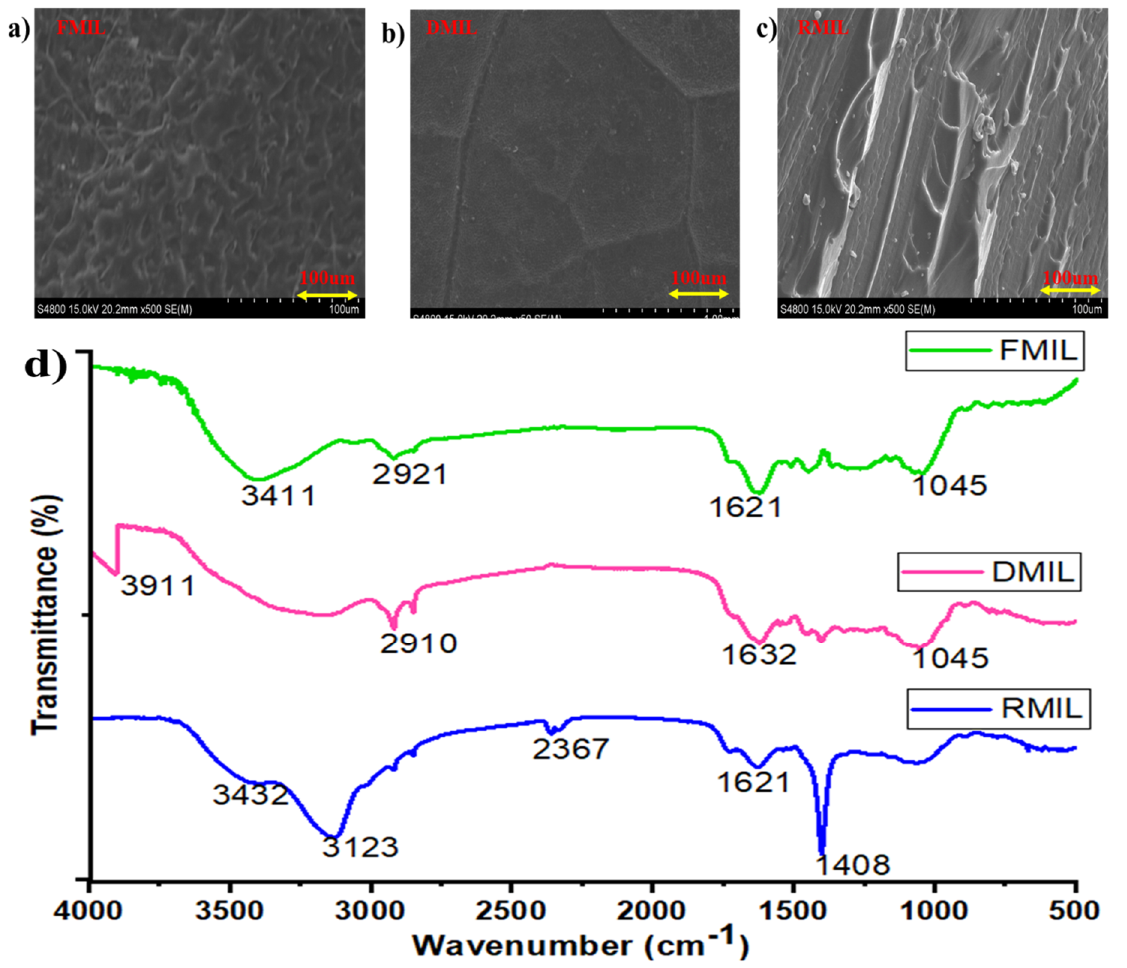
Figure 9. ( a – c ) SEM surface morphology of FMIL, DMIL, and RMIL, ( d ) FTIR spectra of 3 samples used during water collection; Fresh Mangifera indica leaf (FMIL), Dry Mangifera indica leaf (DMIL), and Replicated Mangifera indica leaf (RMIL).